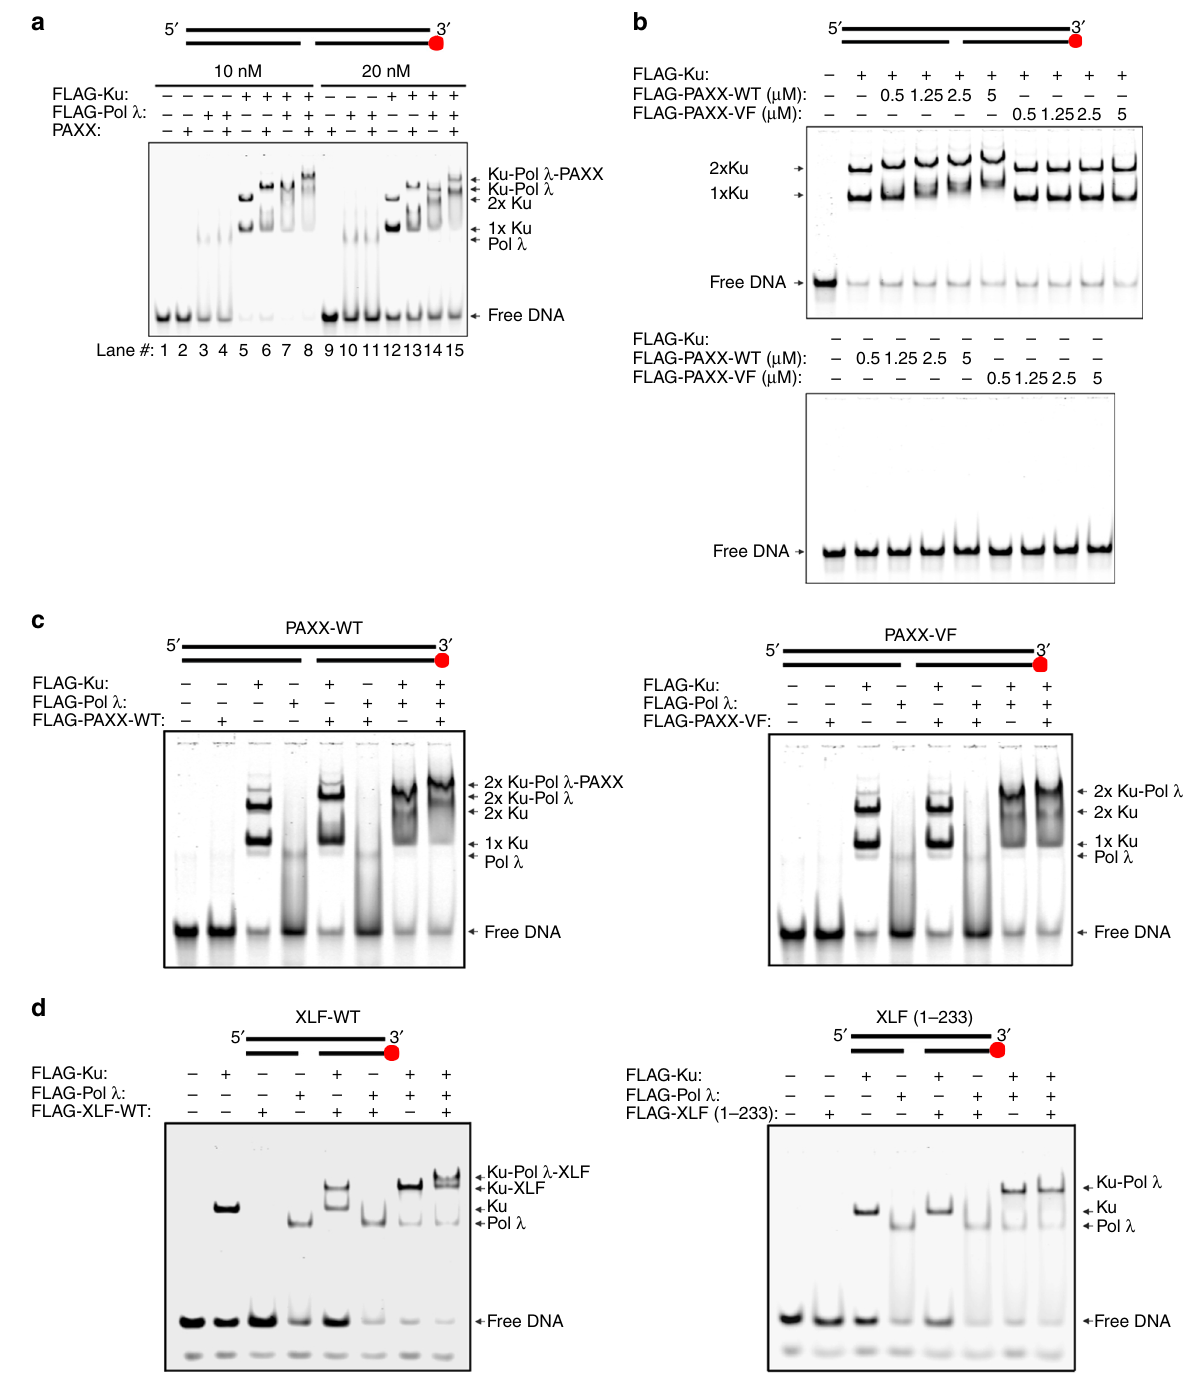
Fig. 4 Interaction of PAXX and XLF with Pol λ requires C-terminal Ku-binding regions. a EMSA showing that interaction of PAXX with Pol λ requires DNA- bound Ku. Reactions were performed with 10 or 20 nM IRDye ® 700-labelled 5nt-gapped dsDNA (90-mer) and the following concentrations of FLAG- Ku70/80 (20 nM), FLAG-Pol λ (40 nM) or cleaved PAXX (100 nM). b Binding of PAXX to DNA-bound Ku requires C-terminal residues V199 and F201 of PAXX. Reactions were performed with 20 nM IRDye ® 700-labelled 5nt-gapped dsDNA (90-mer) and the indicated concentrations of FLAG-PAXX-WT or a FLAG-PAXX-V199A/F201A mutant and FLAG-Ku70/80 (20 nM). c As described in Panel A, except that reactions contained FLAG-Ku (20 nM), FLAG-Pol λ (100 nM), FLAG-PAXX-WT (2.5 μ M, left panel) or a V199A/F201A mutant (2.5 μ M, right panel). d As described in Panel A, except that reactions contained FLAG-Ku (20 nM), FLAG-Pol λ (200 nM), FLAG-XLF-WT (2.5 μ M, left panel) or a C-terminal FLAG-XLF (aa1-233) deletion mutant (2.5 μ M, right